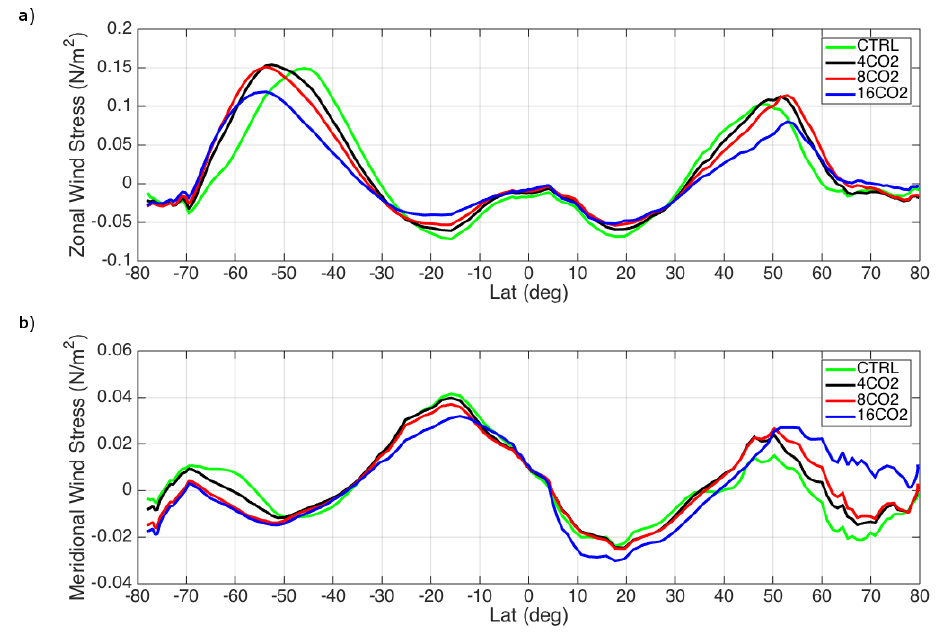
Figure 3. Annual mean intensity of (a) zonal and (b) meridional wind stress components (N/m 2 ) zonally averaged over the Atlantic Ocean (black), 8CO (red) and 16CO (blue) for CTRL (green), 4CO 2 2 2